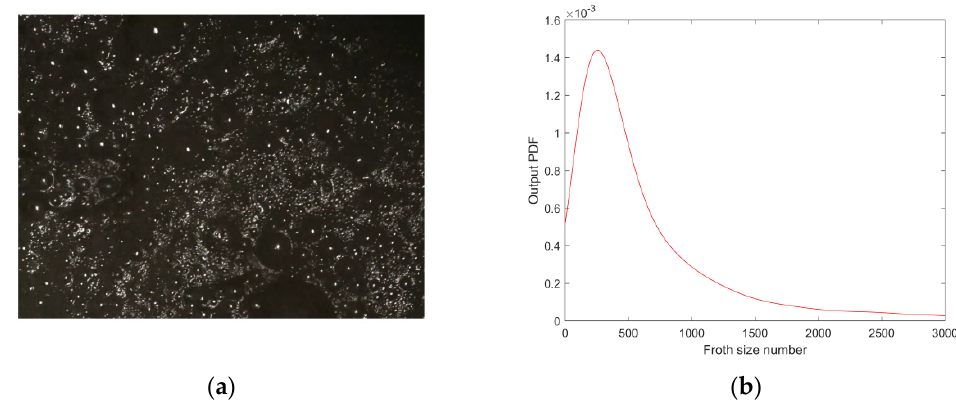
Figure 7. ( a ) Froth image acquired online by flotation cell. ( b ) SD of mineral flotation froth.